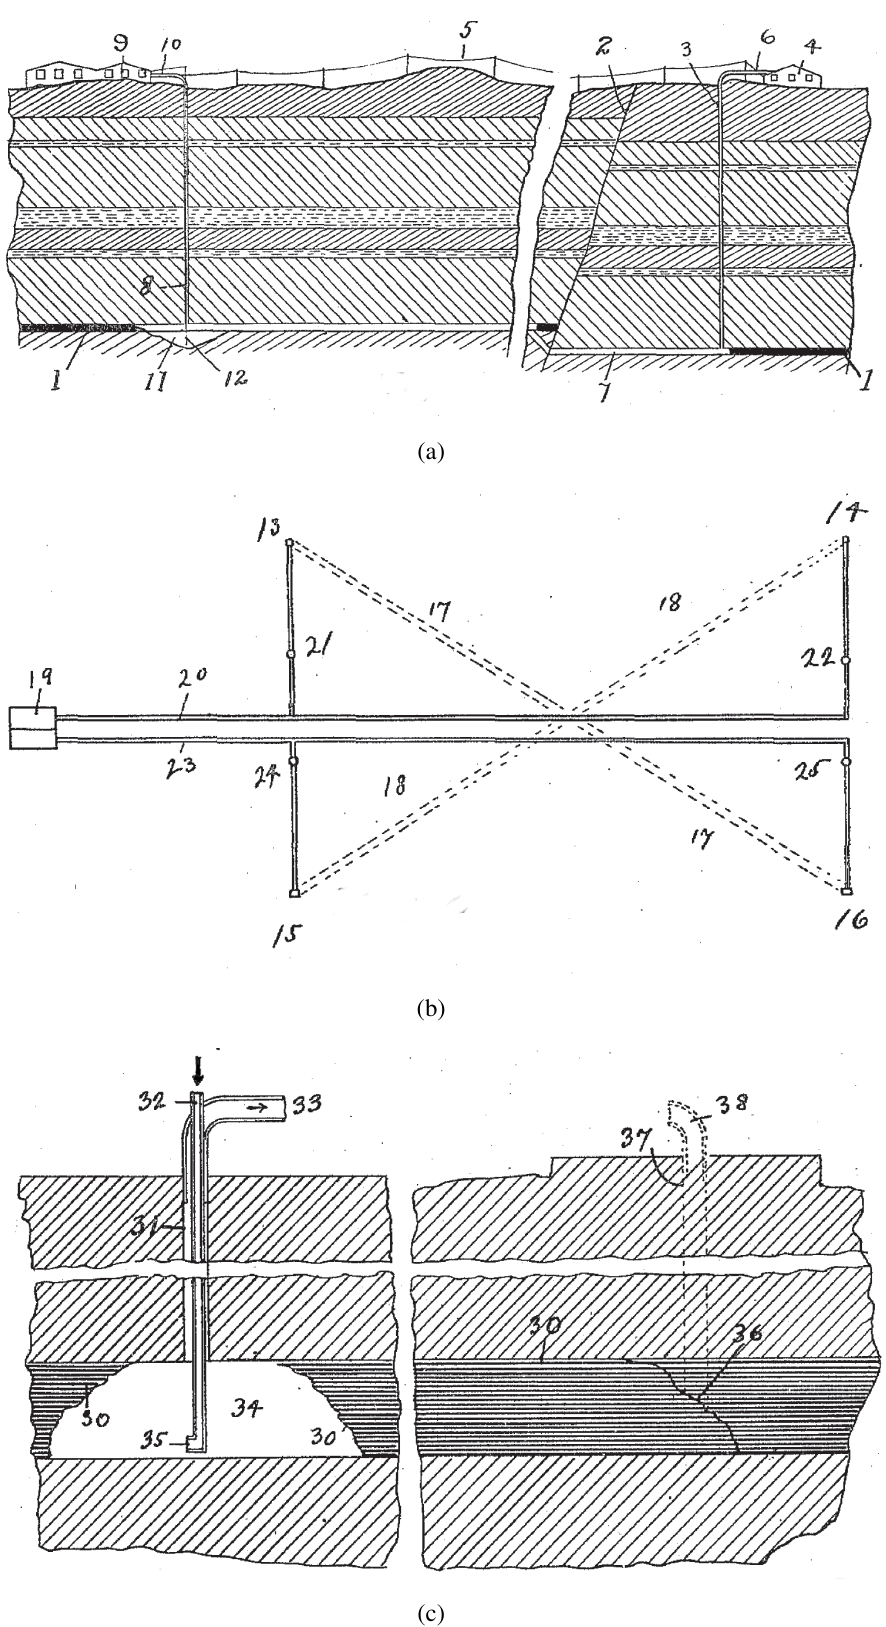
Figure 1. Underground gasification schemes proposed by Betts